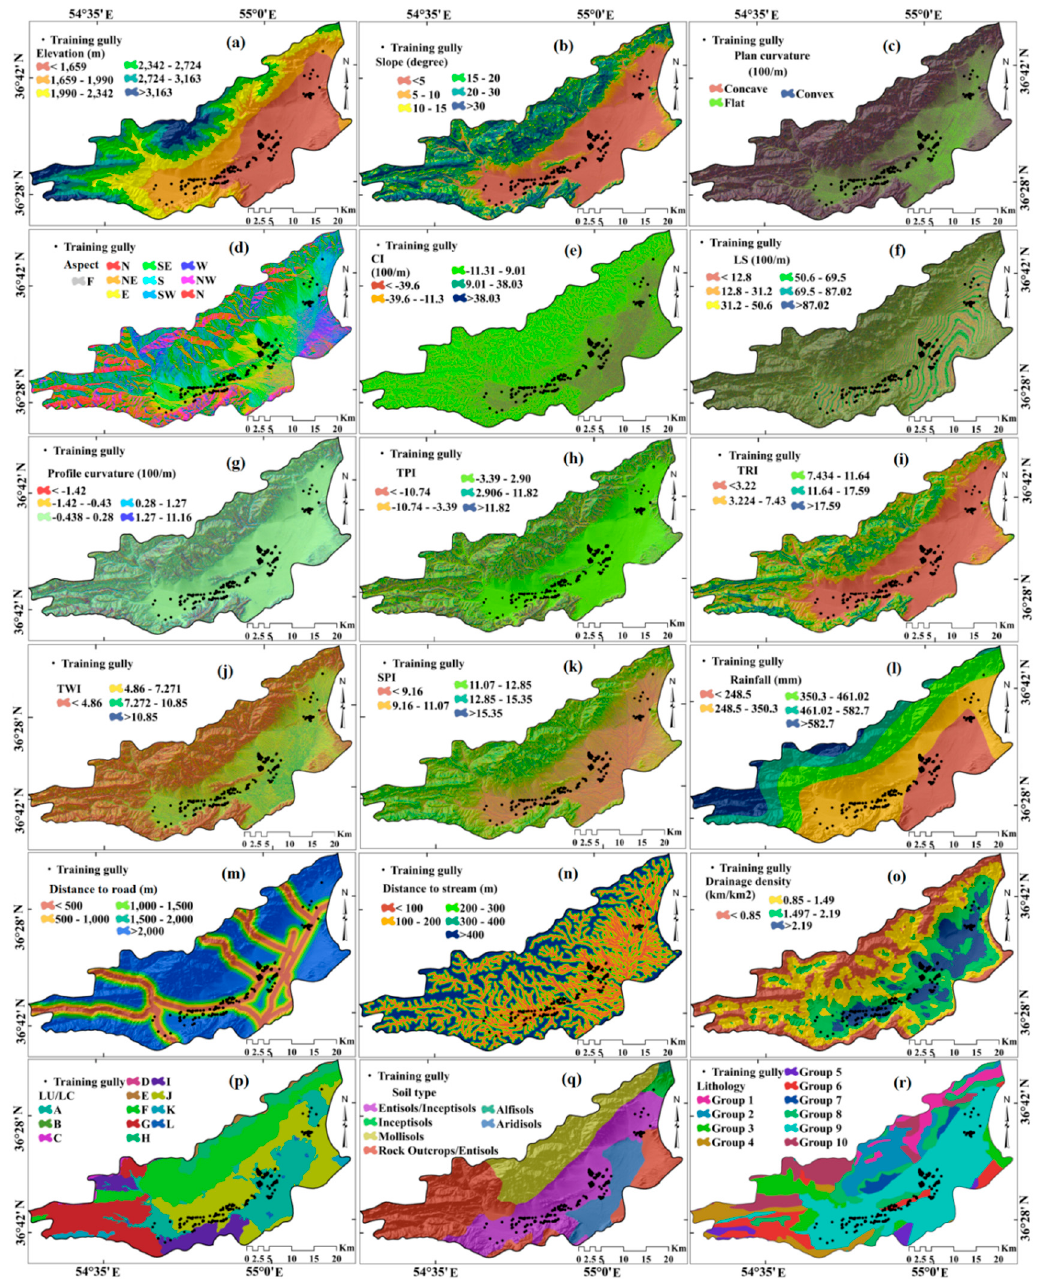
Figure 4. Gully erosion conditioning factors. ( a ) elevation, ( b ) slope, ( c ) plan curvature, ( d ) slope aspect, ( e ) convergence index (CI), ( f ) slope length (LS), ( g ) profile curvature, ( h ) topography position index (TPI), ( i ) terrain ruggedness index (TRI), ( j ) topography wetness index (TWI), ( k ) stream power index (SPI), ( l ) rainfall, ( m ) distance to road, ( n ) distance to stream, ( o ) drainage density, ( p ) land use/land cover, ( q ) soil type, and ( r ) lithology. Table 1. The lithology of the study area.